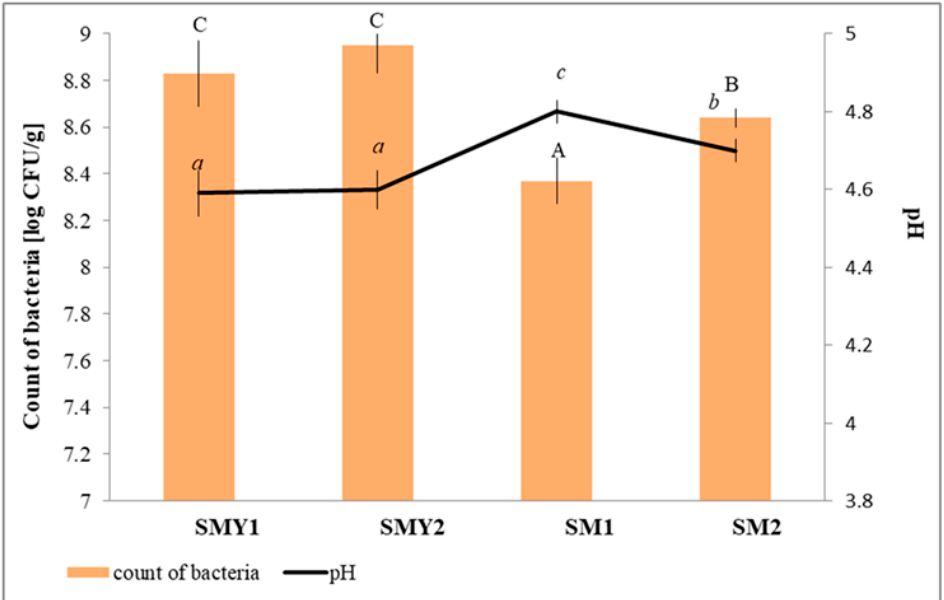
Figure 1. Impact of pumpkin cultivar used and bacterial strain on pH value and the count of LAB bacteria in investigated functional frozen desserts. Explanatory notes: The presented samples are coded according to Section 2; Table 1. The results are expressed as the mean ± standard deviation ( n = 3). Mean values denoted by the same letters (upper case letters—in regard LAB count, and lower-case letters—in regard to pH value) do not differ significantly ( p > 0.05).